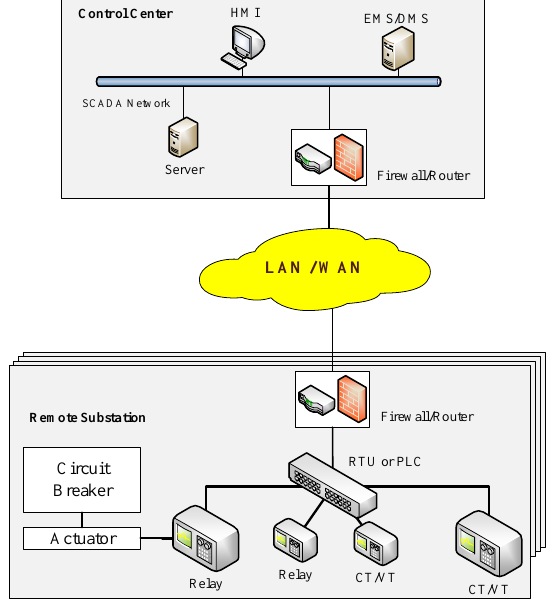
Figure 1. Architecture of a SCADA system.